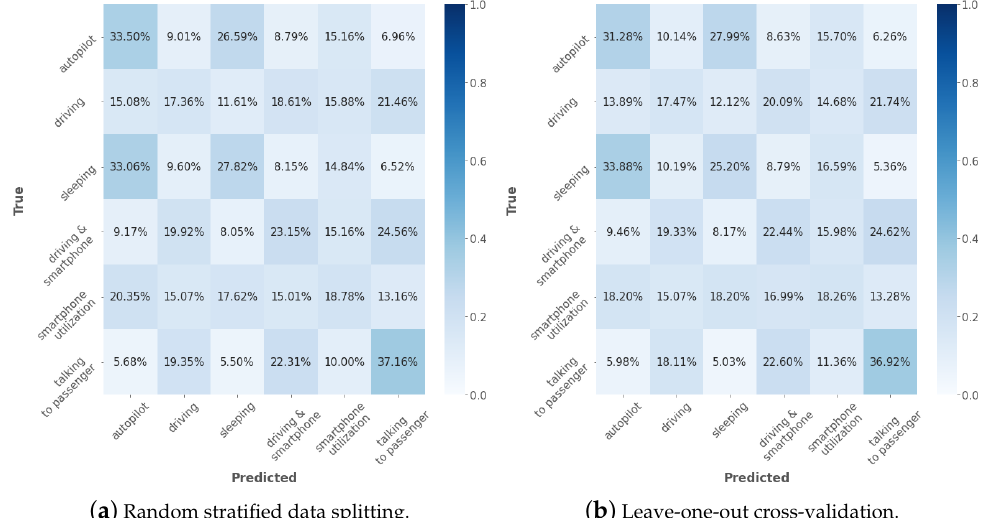
Figure 7. Confusion matrices of the obtained classification results using Ensemble classifier